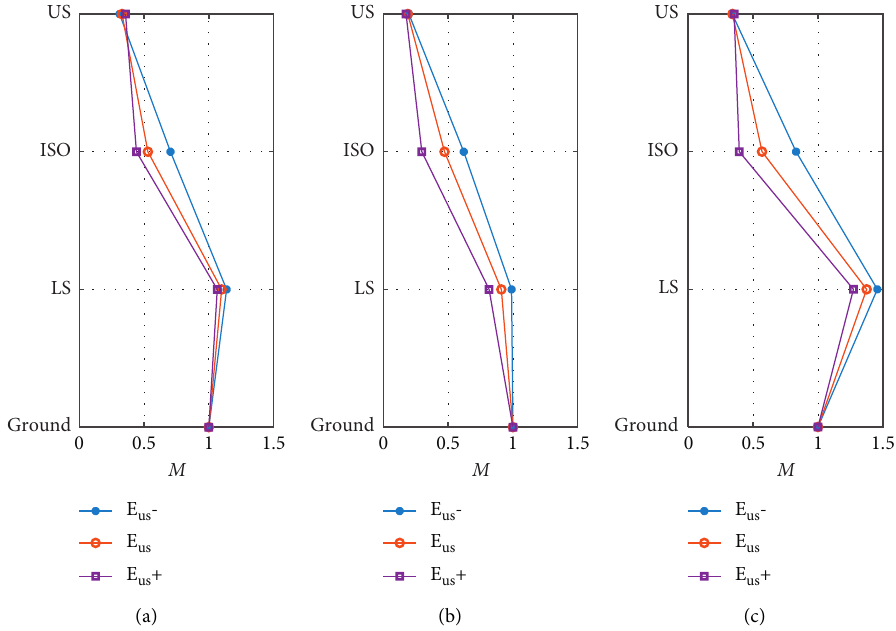
Figure 15: The magnification factor M for Case 2: (a) El Centro-EW, (b) Taft-NS, and (c) Hachinohe-NS.